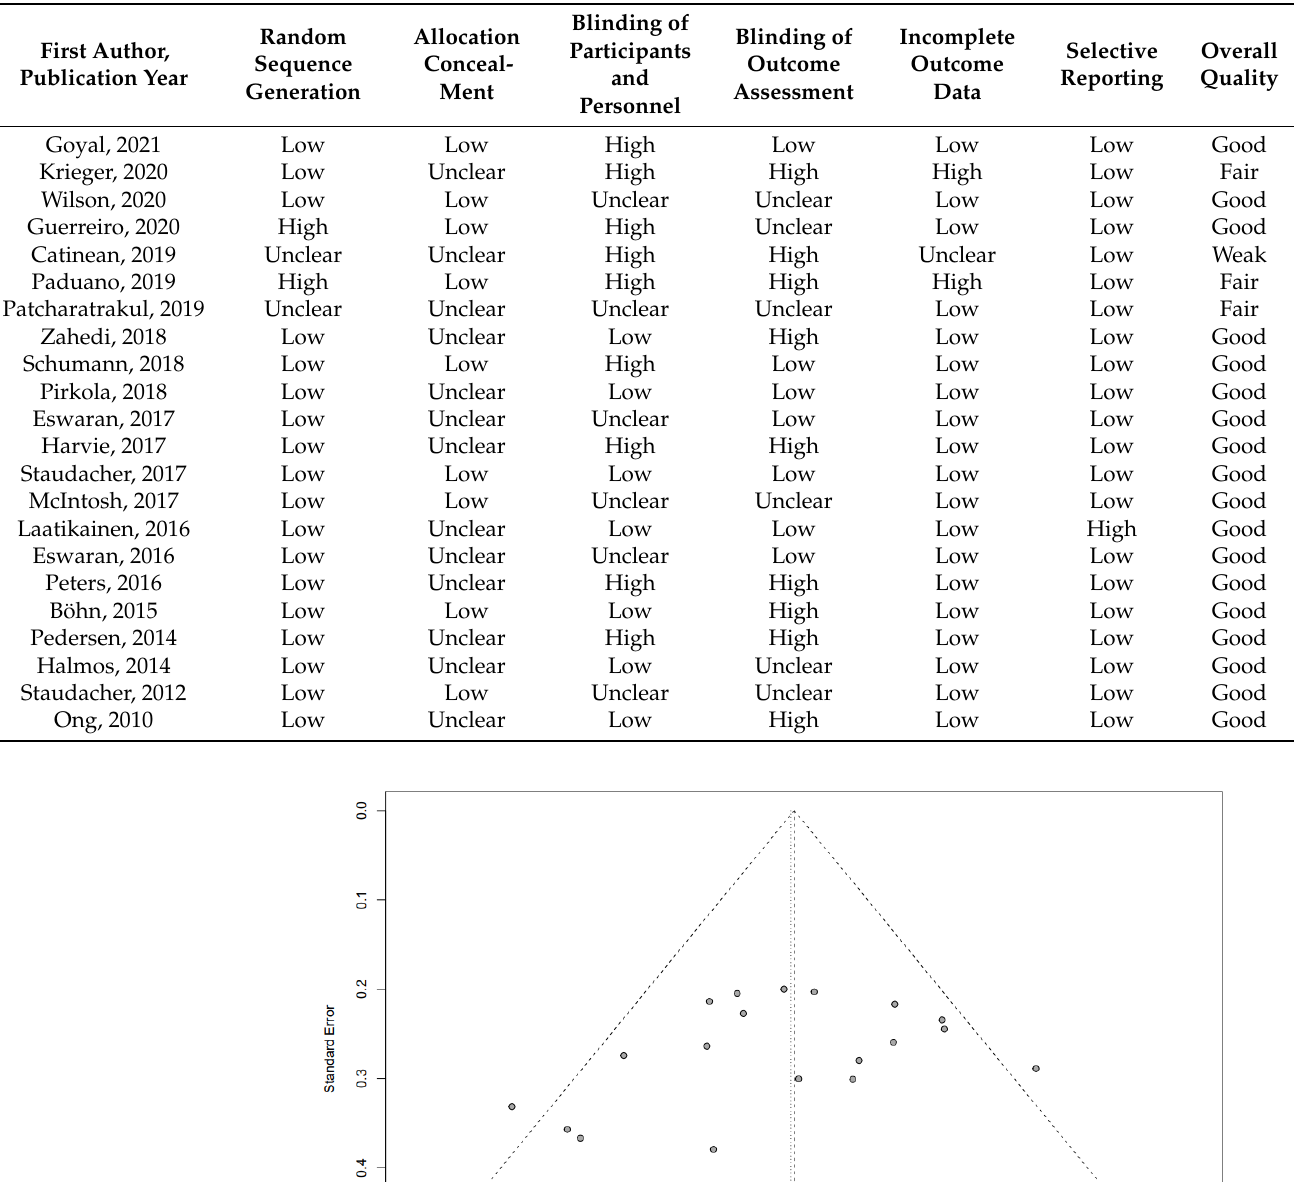
Table 3. Risk of bias.